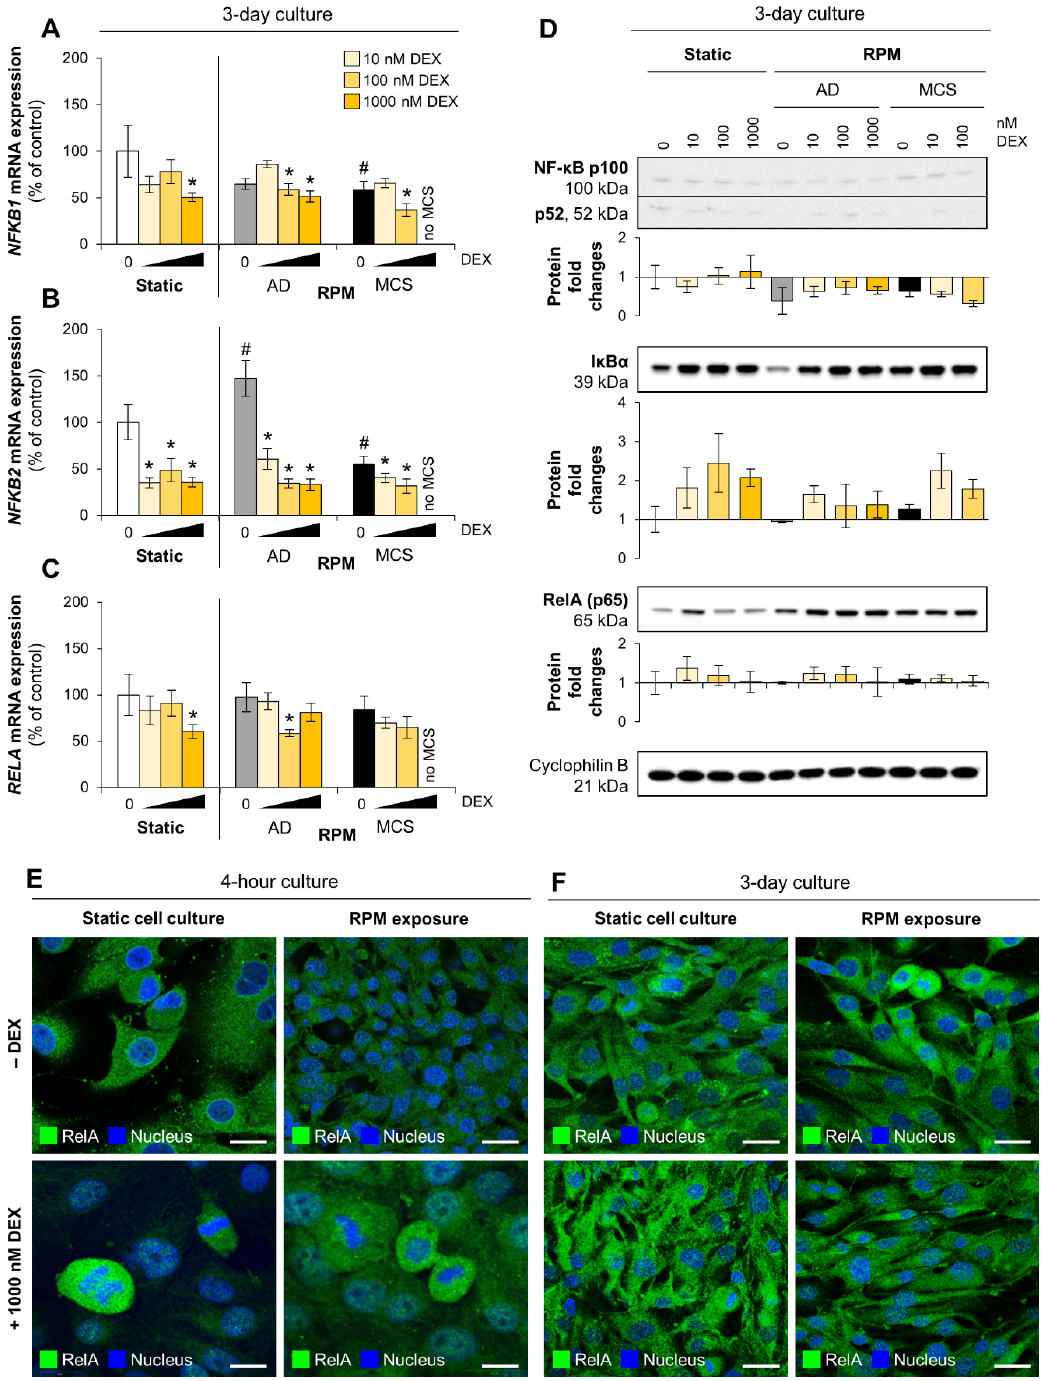
Figure 3. Effect of DEX on NF- κ B family members in FTC-133 cells. ( A ) NFKB1 mRNA expression; ( B ) NFKB2 mRNA expression; ( C ) RELA mRNA expression. Depicted are means of relative mRNA levels ± standard deviations ( n = 5). *: p < 0.05 vs. DEX-free samples. # : p < 0.05 vs. static cultures; ( D ) Western blots indicate protein levels of regulated genes after three days. Representatives of each of the three replicates are shown. Diagrams describe relative fold changes to control. AD: adherently growing cells; MCS: multicellular spheroids. ( E, F ) Immunofluorescence shows only minor translocation of RelA (green) into the nucleus (blue; 4’,6-diamidino-2-phenylindole (DAPI)-stained) in FTC-133 cells. Scale bars: 20 µm.